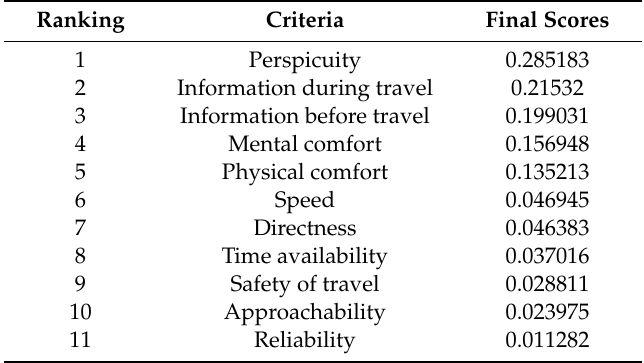
Table 3. Final fuzzy scores of the criteria for Level 2 considering branch connections.